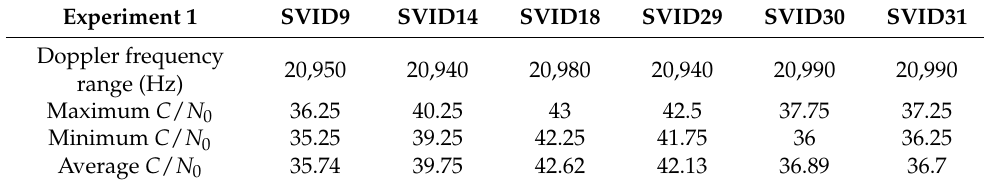
Table 2. Statistical table of Experiment 1 Results.